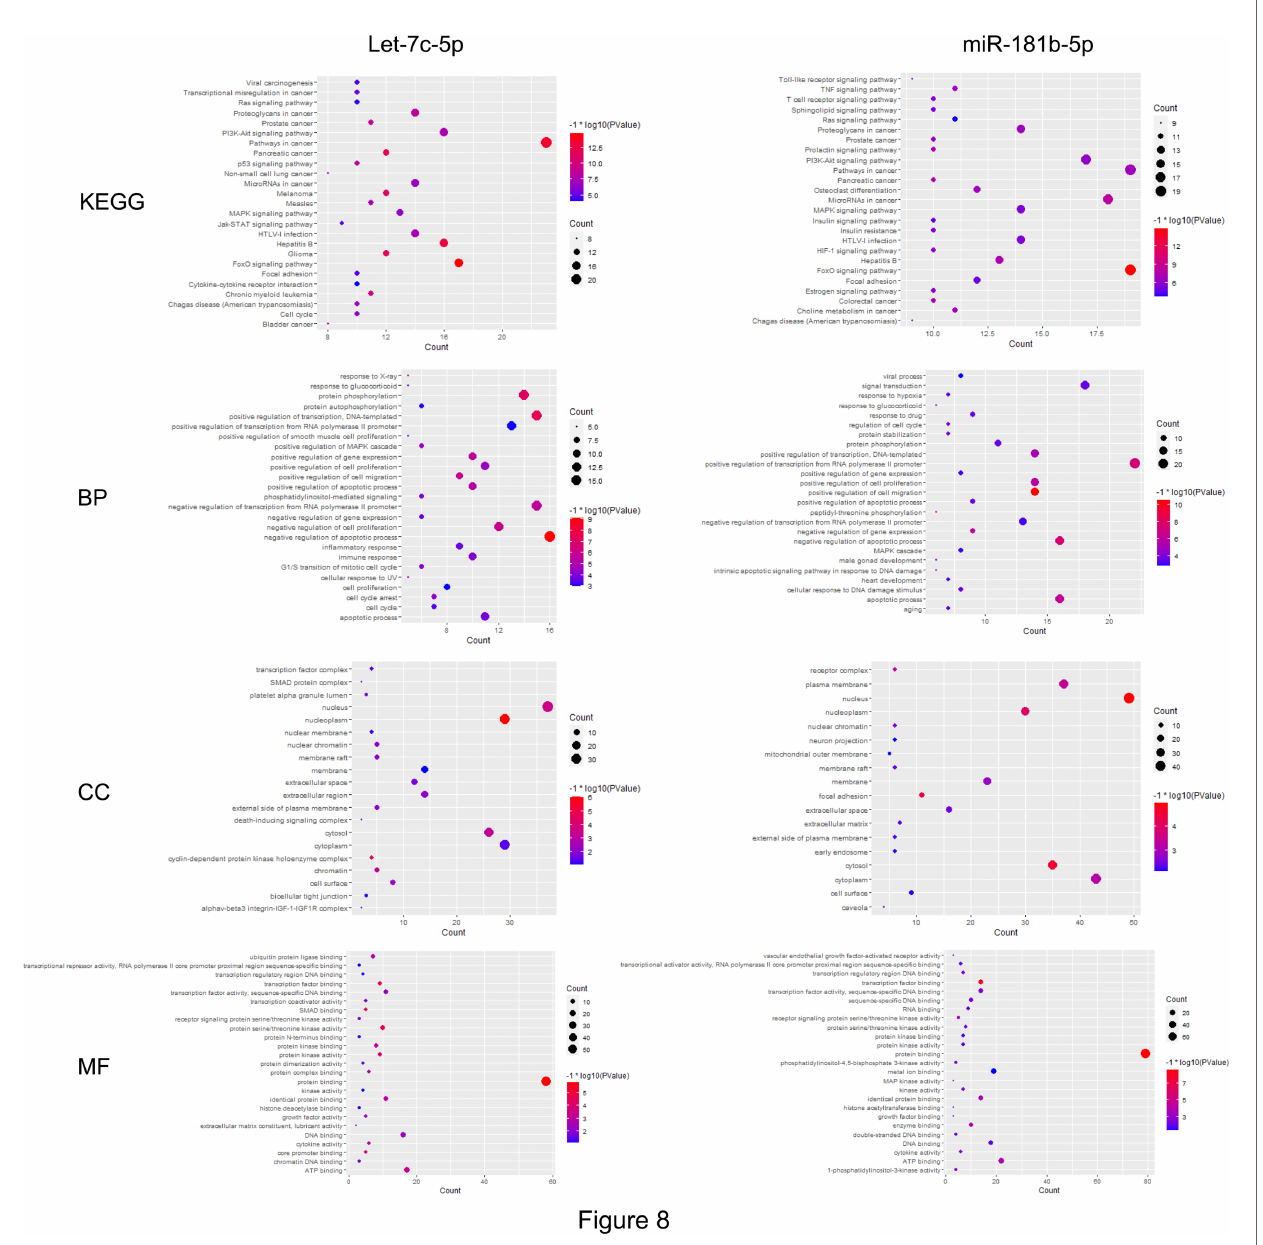
FIGURE 8 | The common targets analyzed by KEGG and GO enrichment. Results of KEGG and GO (including BP, CC, MF) enrichment analysis for the targets gene of let-7c-5p and miR-181b-5p, respectively ( p ≤